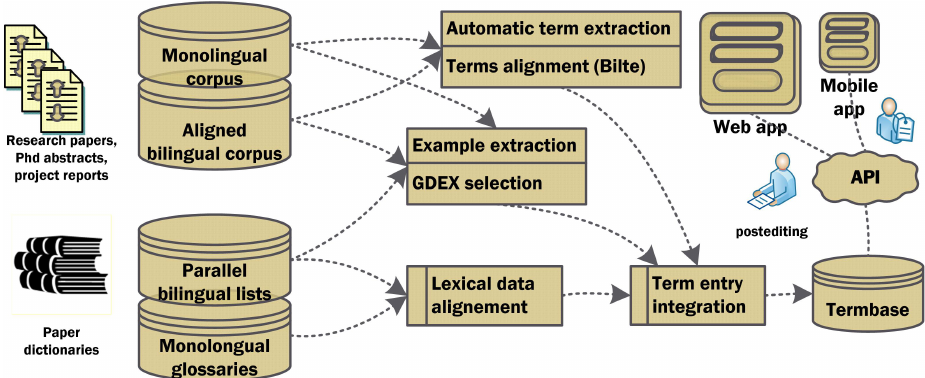
Figure 3. The pipeline for terminology compilation (termbase